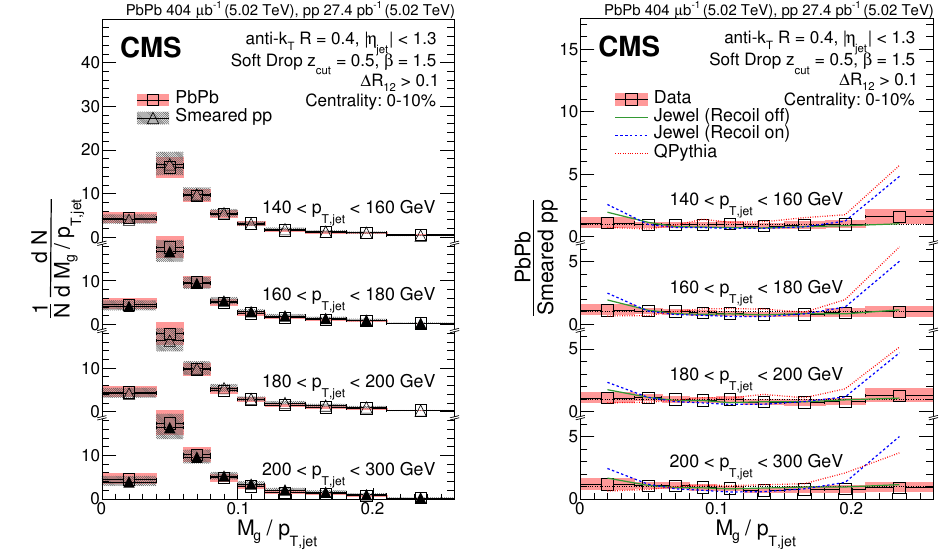
Figure 6 . (left) The p jet dependence of M g =p jet , for PbPb events in the centrality class 0{10%, for T T the (0 : 5 ; 1 : 5) SD setting. Results are compared to the smeared pp spectra. (right) The ratio of PbPb data over smeared pp data. The heights of the colored boxes statistical (systematic) uncertainties. Statistical uncertainties are less than the marker sizes. The ratios are compared to smeared jewel and q-pythia generators, shown in blue and green,